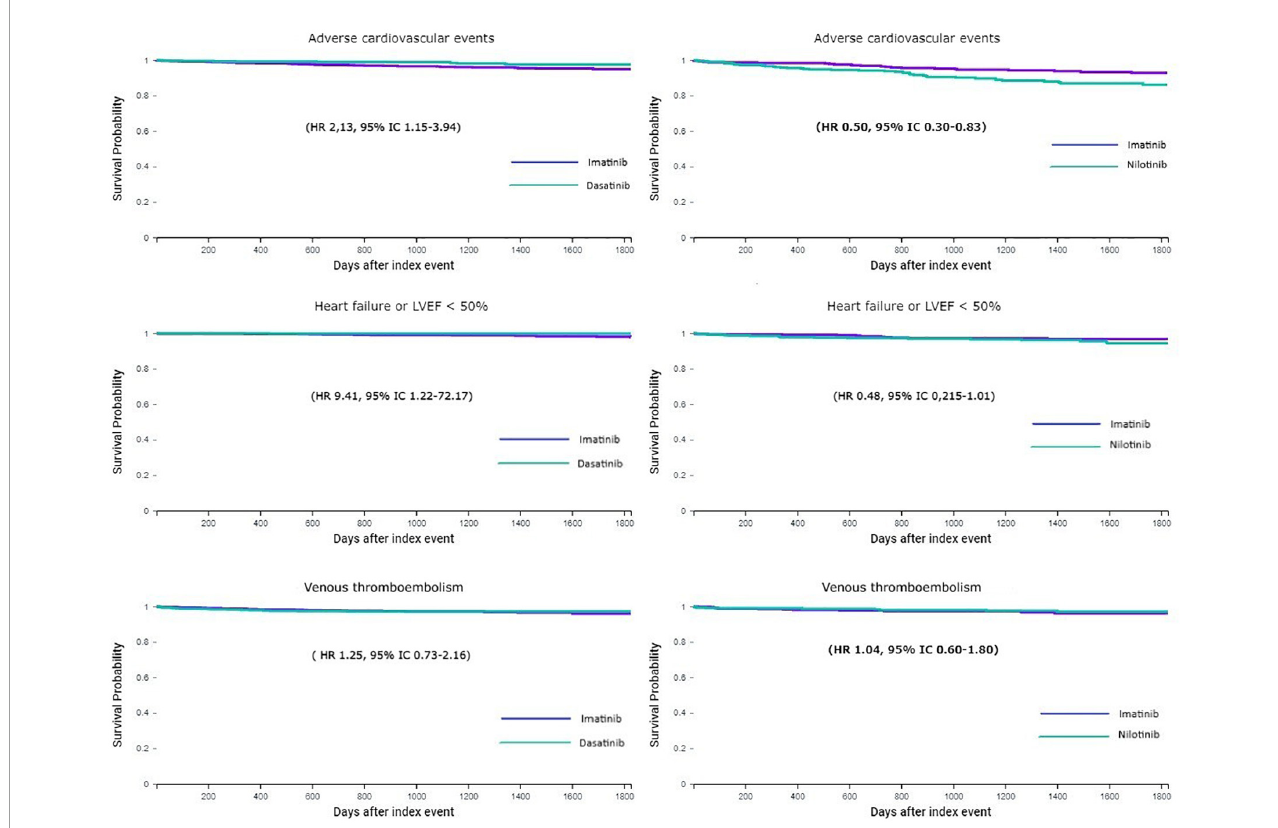
FIGURE1 5-year Kaplan–Meier curves for adverse cardiovascular or cerebrovascular events, heart failure or LVEF < 50%, and VTE or pulmonary embolism in patients treated with imatinib vs. dasatinib ( left column) and imatinib vs. nilotinib ( right column). LVEF, left ventricular ejection fraction; HR, hazard ratio; CI, confidence interval; VTE, venous